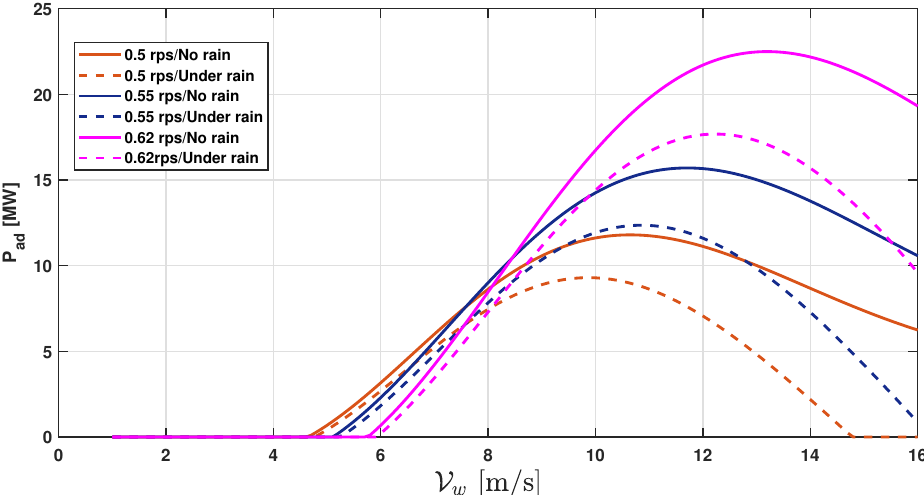
Figure 10. Analytical results of P ad − V w corresponding to different rotor speeds ω m .